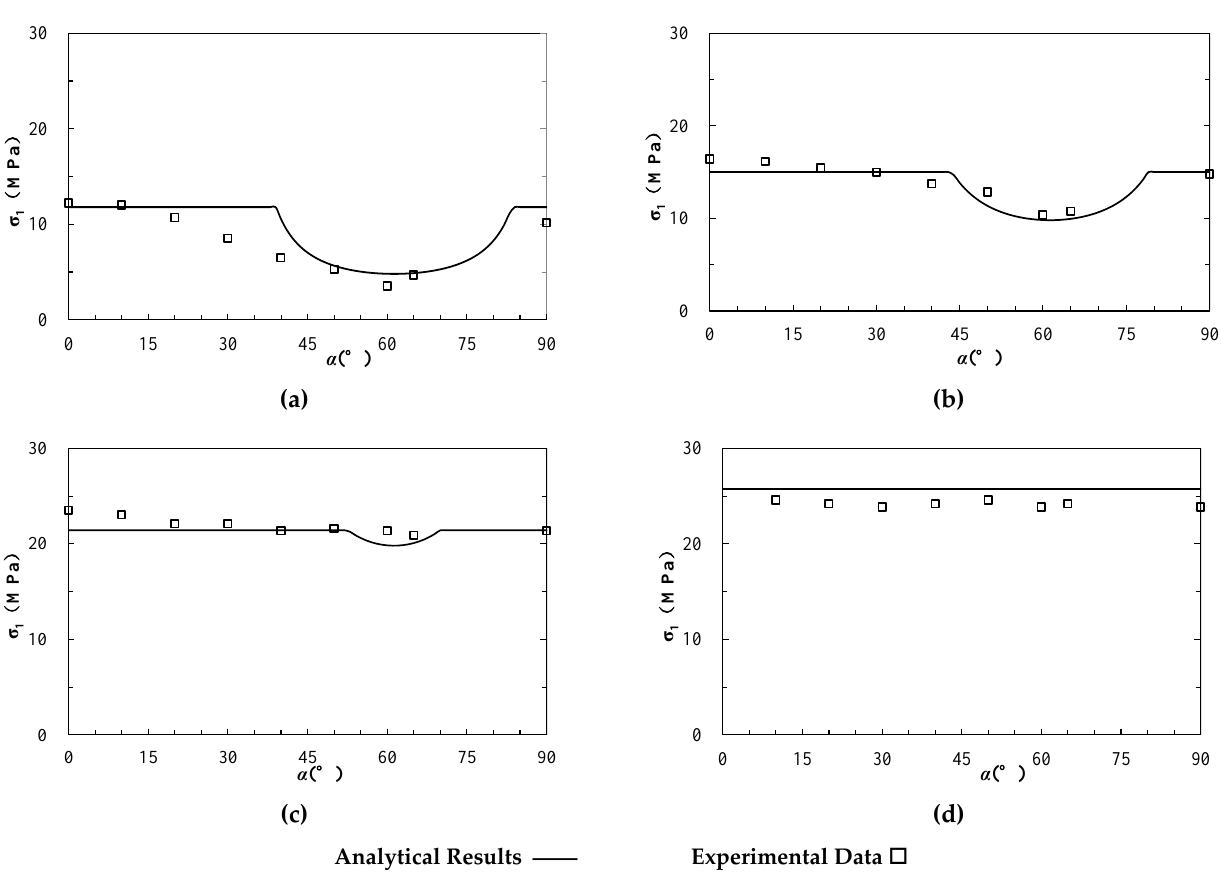
Figure 6. The analytical and experimental strength of anisotropic jointed plaster of Paris (modified based on [3]). ( a – d ) represent the results under triaxial compression at different confining pressure ( 𝜎 3 ) of 0.5, 2, 5, and 7 MPa, respectively.